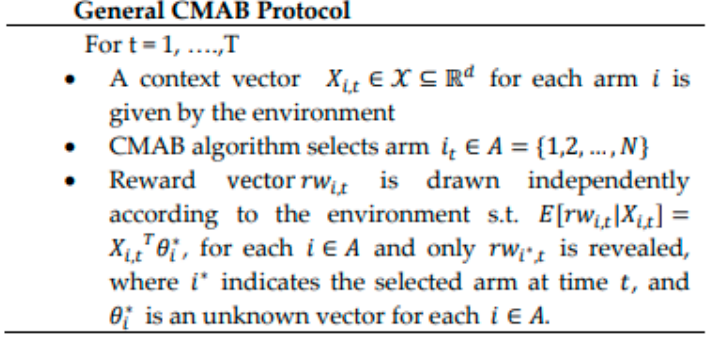
Figure 2. General CMAB